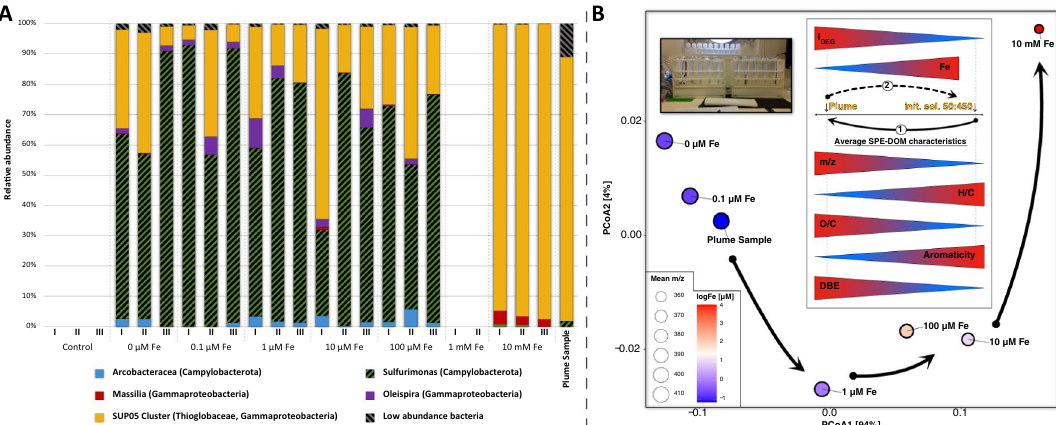
Figure 4. ( A ) Taxonomy plots of the bacterial communities within the incubations after 7 days. Only plots with a minimum of 1000 merged sequences per sample are shown. ( B ) Principal coordinate analysis depicting the variability of SPE-DOM composition in the incubation experiments. Average SPE-DOM compositions were calculated for the different levels of spiked Fe. The embedded sketch depicts the incubations plot with respect to selected average SPE-DOM characteristics (m/z, H/C, O/C, AI mod and DBE as well as the degradation index I DEG 37 ) relative to the original plume sample and the composition of the initial solution (50:450 (P:C) medium to plume sample ratio) mixture. Path number 1 indicates the general change presumably associated with microbial growth, whereas the reverse path number 2 will in part be associated with